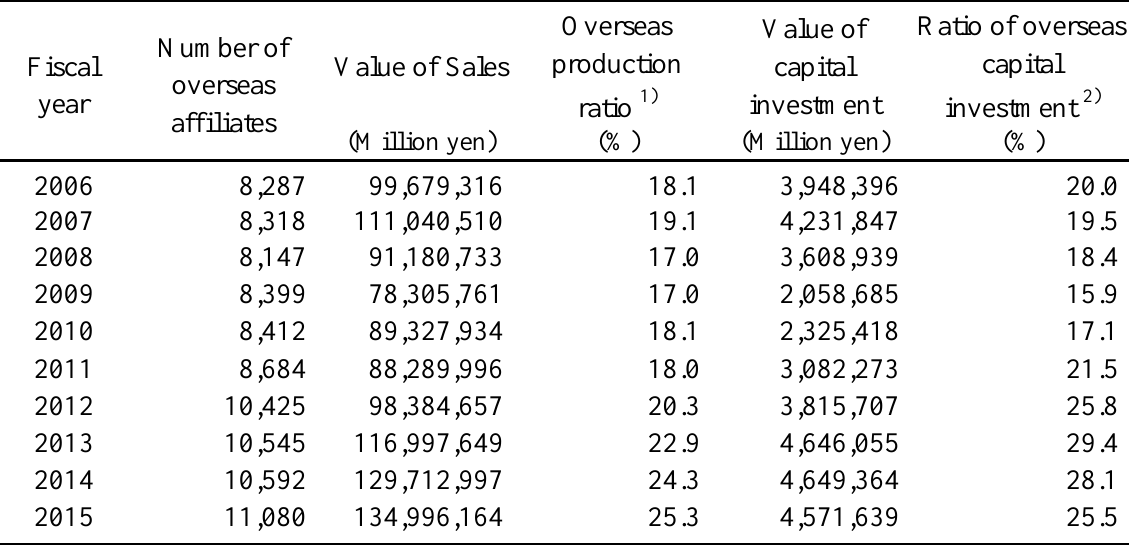
Trends of Overseas Affiliated Company (Manufacturing